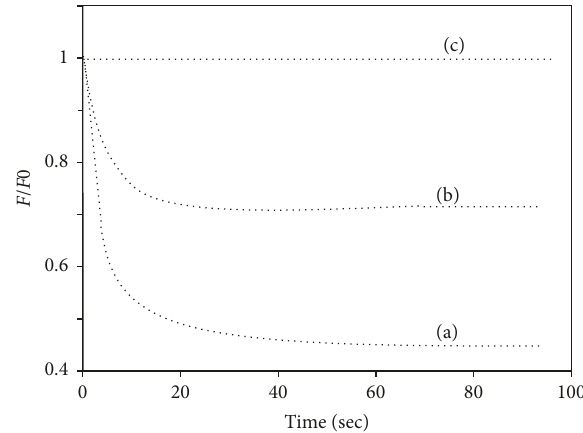
Figure 2: Kinetic studies indicated that the decrease in fluorescence intensity of YOYO intercalated in different DNAs after the addition of 1.2 𝜇 M 𝛼 -PrP. Traces (a), (b), and (c) are gcDNA, mDNA, and atDNA, respectively. DNA concentrations 1 𝜇 M in phosphate, dye 20 nM (dye to phosphate ratio = 1: 50). 𝐹 0 fluorescence intensity of the dye before the addition of the prion protein and 𝐹 the fluorescence values after the addition of the protein. Temperature 20 ∘ C. Excitation 485 nm; emission 505